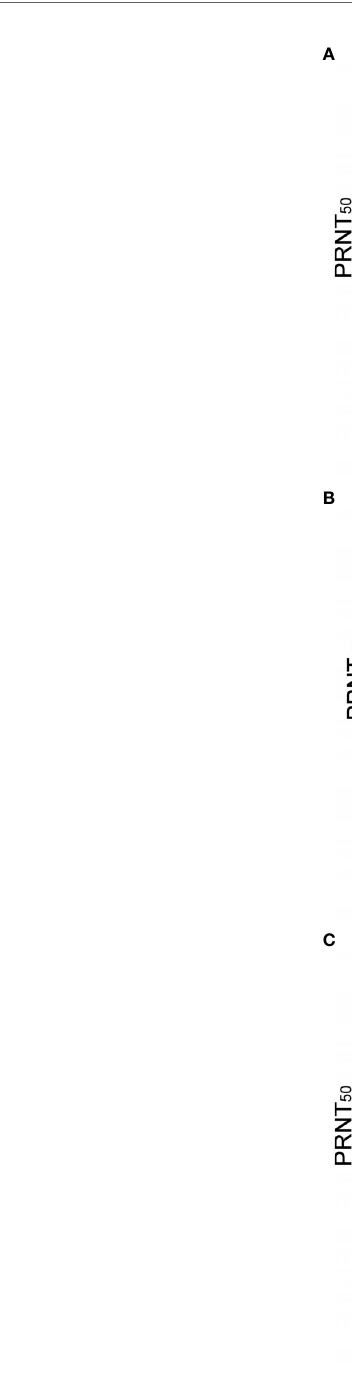
FIGURE 3 | Immune Response After Immunization with Monovalent, Triple Mix, or Trivalent Vaccines. Mice were immunized (IM) twice (Day 0 and 28) with the respective vaccine or TBS. VEEV PRNT 50 (A) , WEEV PRNT 50 (B) , and EEEV PRNT 50 (C) . On Day 28, the geometric mean MVA-WEEV PRNT 50 was signi fi cantly greater than the Trivalent and TBS control groups and on Day 42, the MVA-WEEV geometric mean PRNT 50 was signi fi cantly greater than the TBS group (p < 0.01). On Day 14, the geometric mean MVA-EEEV PRNT 50 was signi fi cantly greater than the Trivalent group and TBS control (p < 0.0001). On Day 42, the MVA-EEEV geometric mean PRNT 50 was signi fi cantly greater than the TBS control (p < 0.01). Five animals per group were evaluated at each time point for immune